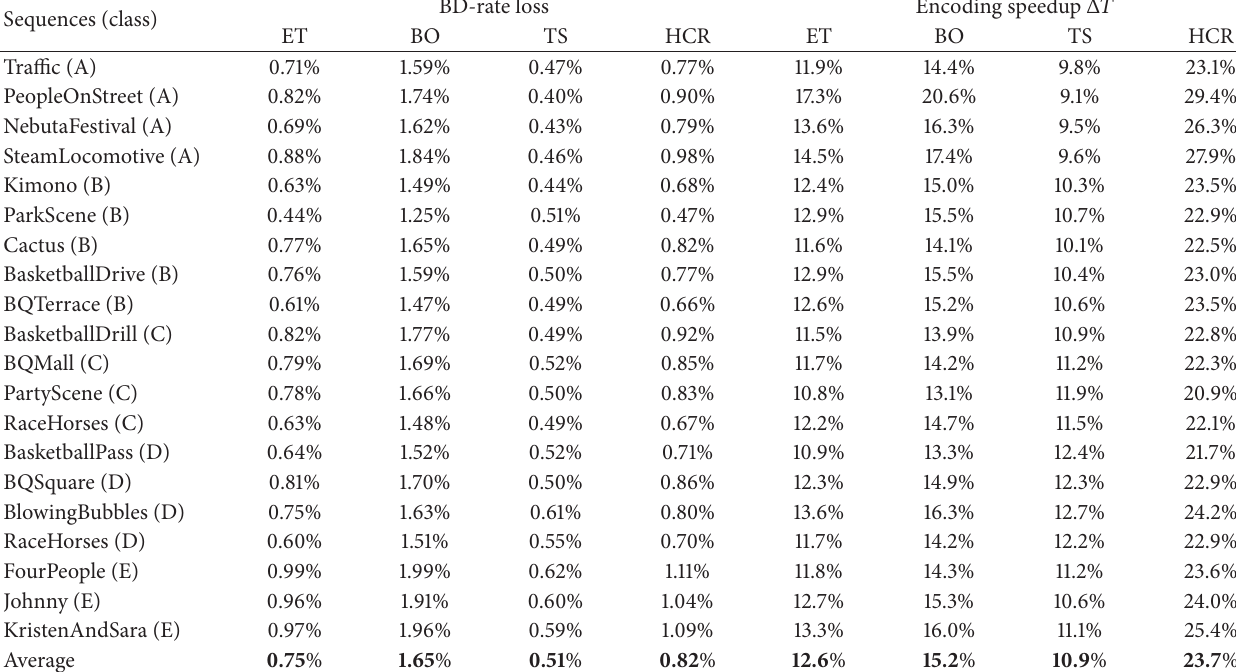
Table 7: BD-rate loss and encoding